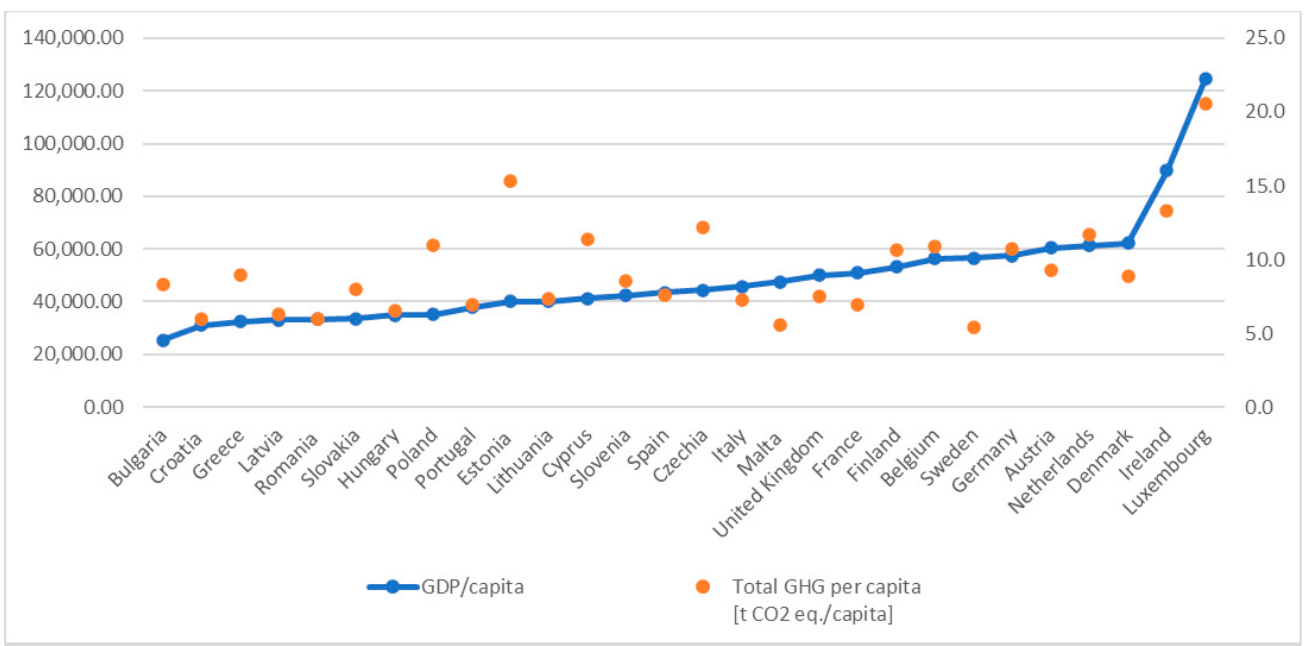
Figure 4. Environmental Kuznets curve between the GDP per capita and the total GHG consumption per capita in 2019.